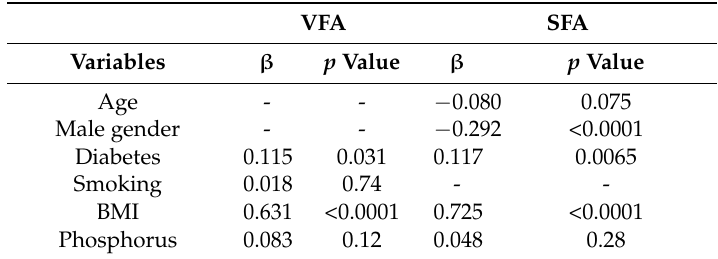
Table 2. Relationships between abdominal fat levels and baseline variables according to multivariate regression